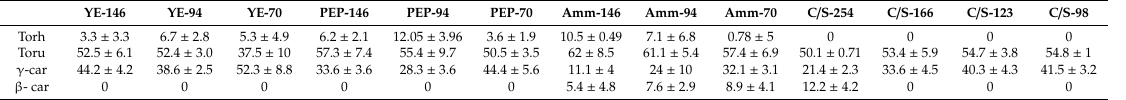
Table 5. The percentage of individual carotenoids, γ -carotene, β -carotene, torulene, and torularhodene in the carotenoid profile extracted from Rhodotorula glutinis